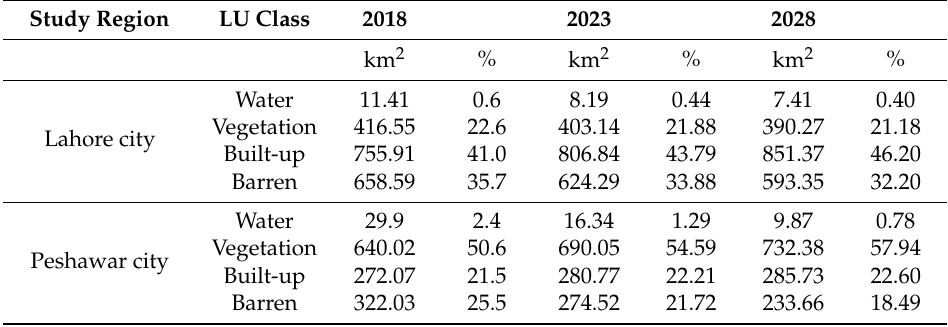
Table 8. Predicted LULC for different classes in 2023 and 2028 for Lahore (top) and Peshawar City (bottom).